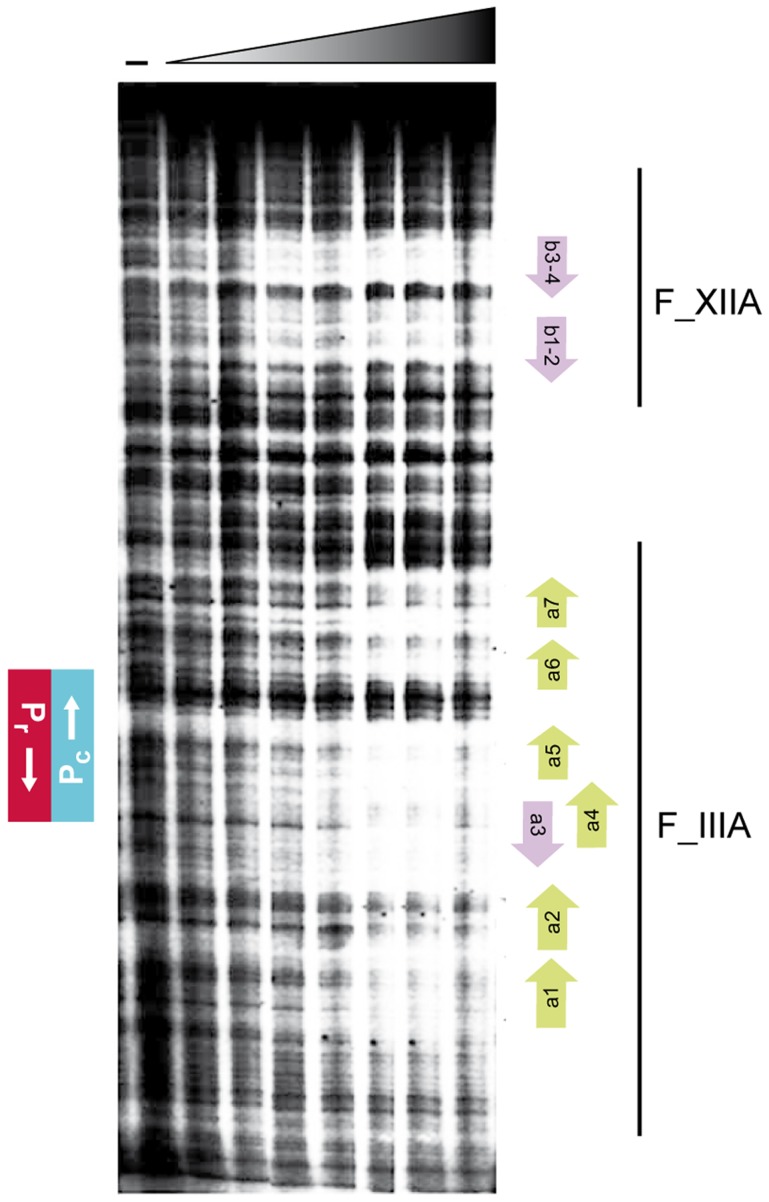
Footprint analyses of the binding of RcoLS20 to the rcoLS20 - -gene 28 intergenic region.Fragment V, end-labeled at the Pc template strand, was analyzed for binding of RcoLS20-His. First lane (−) was not incubated with protein. Concentrations of RcoLS20-His, increasing by two-folds, ranged from 0.11 to 7.04 µM. The positions of the Pc and Pr promoters are indicated on the left. Bars on the right reflect the regions covered by Fragments IIIA (F_IIIA) and XIIA (F_XIIA). Positions of motifs a1–a7 and b1–b4 are indicated with green or purple arrows at the right.